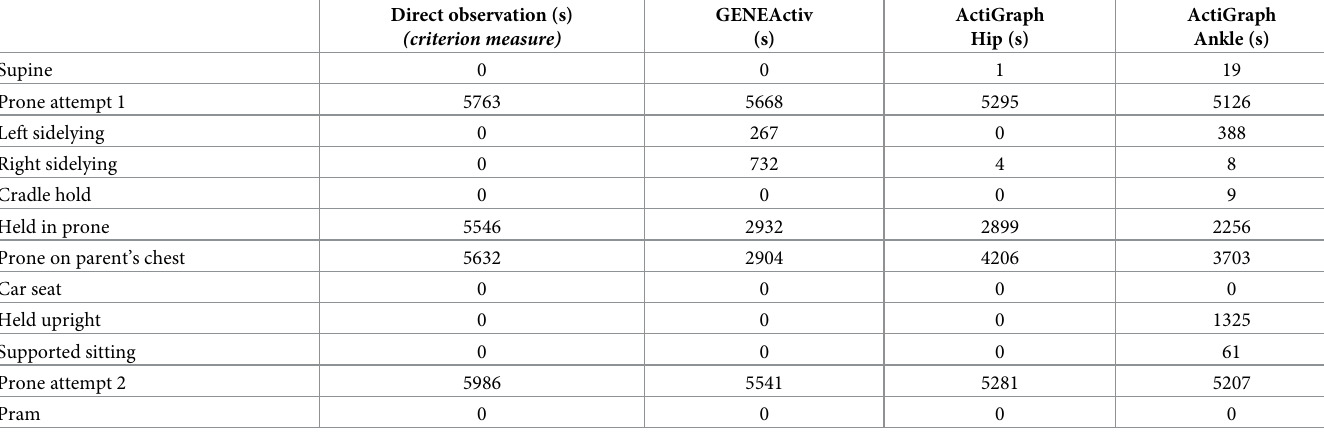
Table 3. Total seconds prone recorded by direct observation, GENEActiv, ActiGraph Hip and ActiGraph Ankle for each position (N =